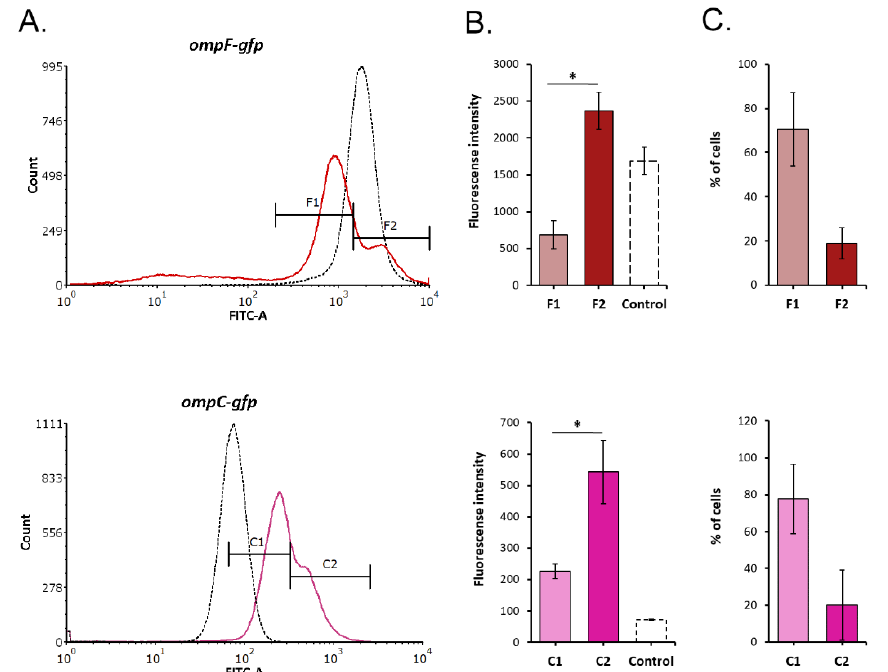
Figure 6. Fluorescence heterogeneity of Y. pseudotuberculosis 488 transformed with ompF/ompC promoter-fused GFP reporter constructs following treatment with a sublethal dose of carbenicillin monitored by flow cytometry. ( A ) Fluorescence histograms; ( B ) fluorescent intensity of subpopulations; ( C ) the percentage of cells in each subpopulation. All results are expressed as mean ± standard deviation between three experimental trials. An asterisk indicates p -value < 0.05 between groups. Significance was calculated using one-way ANOVA. The histograms from a single representative experiment are shown. F1, F2, and C1, C2 — subpopulations of Y. pseudotuberculosis 488 with low/high GFP fluorescence.